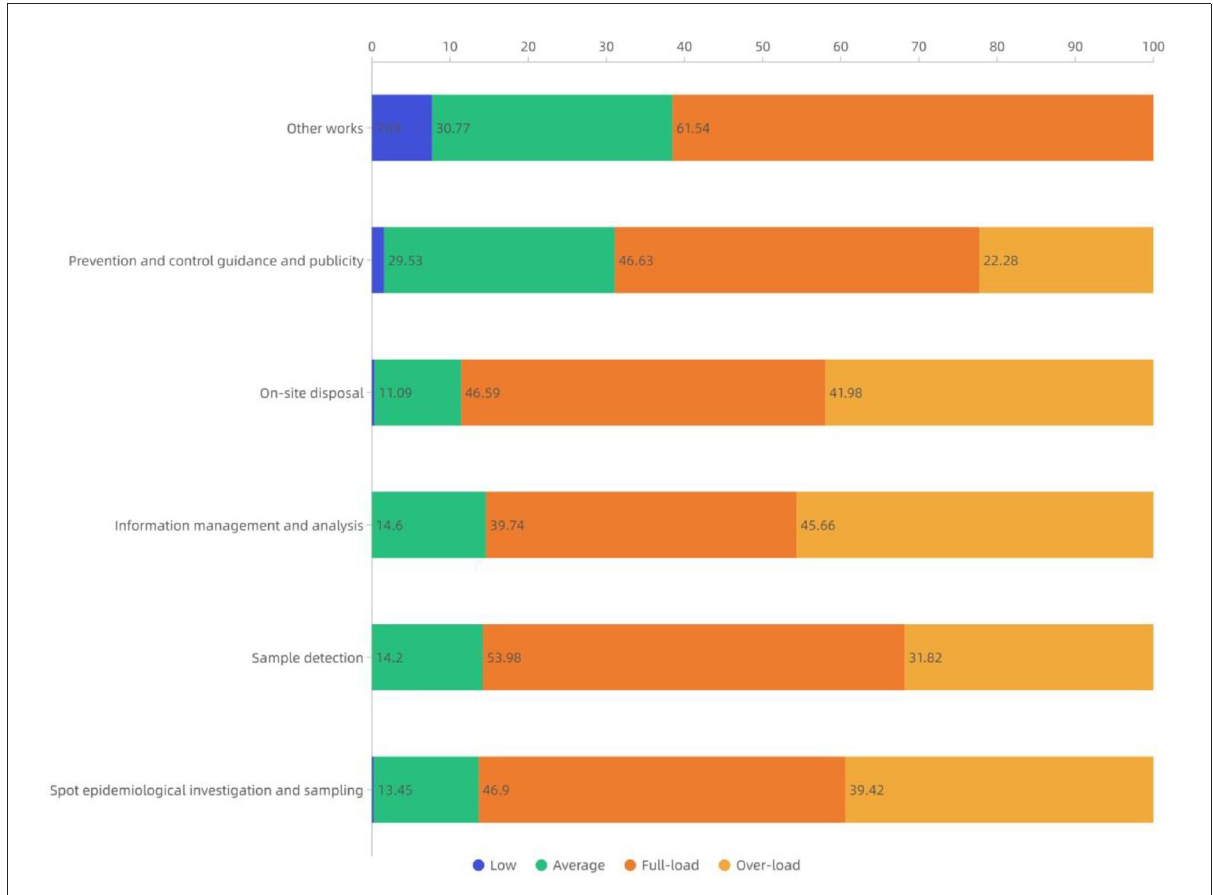
FIGURE4 Distribution of work stress in different epidemic prevention and control duties during COVID-19 pandemic within Beijing Disease Prevention and Control